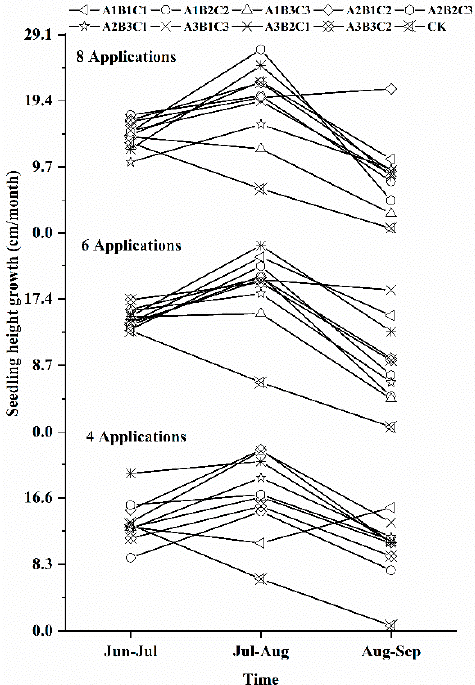
Figure 1. Dynamic changes in seedling height growth under different fertilization ratios and frequencies. Table. 5 Effects of different fertilization ratios and frequencies on root collar